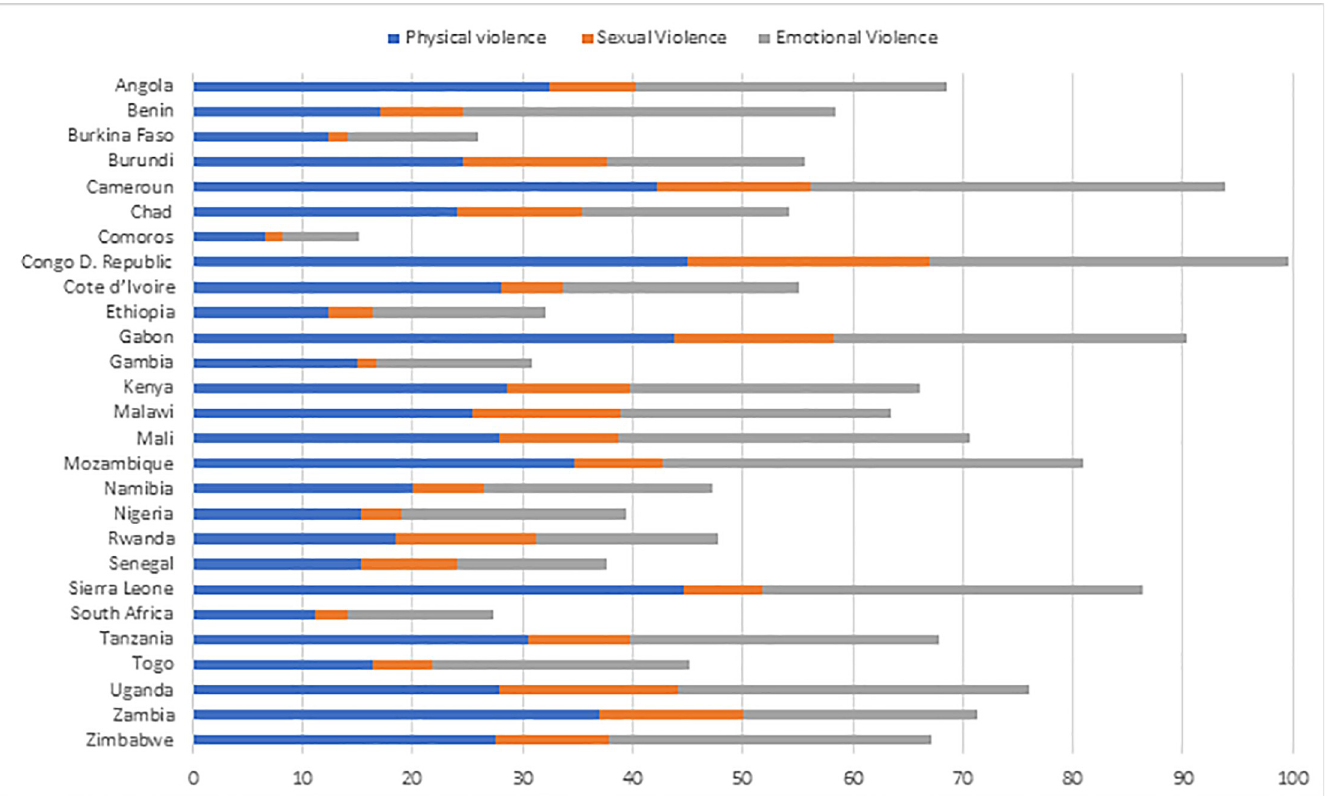
Fig 1. Prevalence of IPV sub-types among urban women in